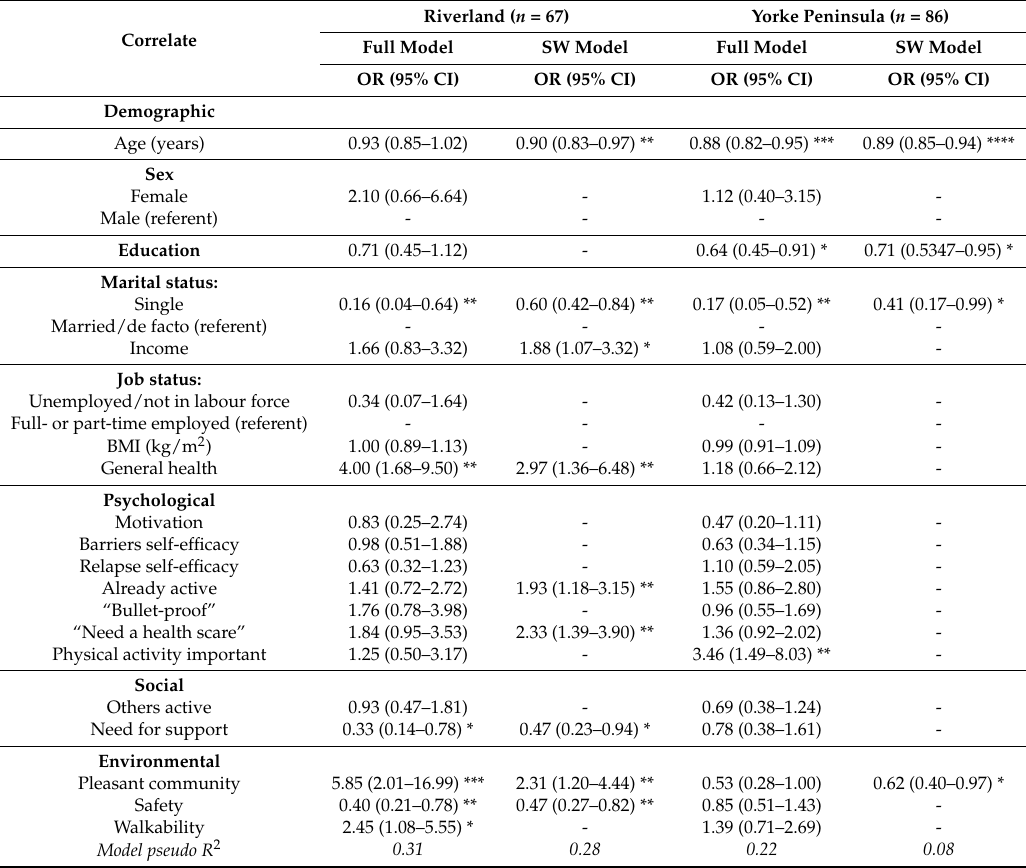
Table 2. Full and parsimonious ordinal logistic regression model results: odds ratios (OR) and 95% CI for included independent variables in predicting pedometer step